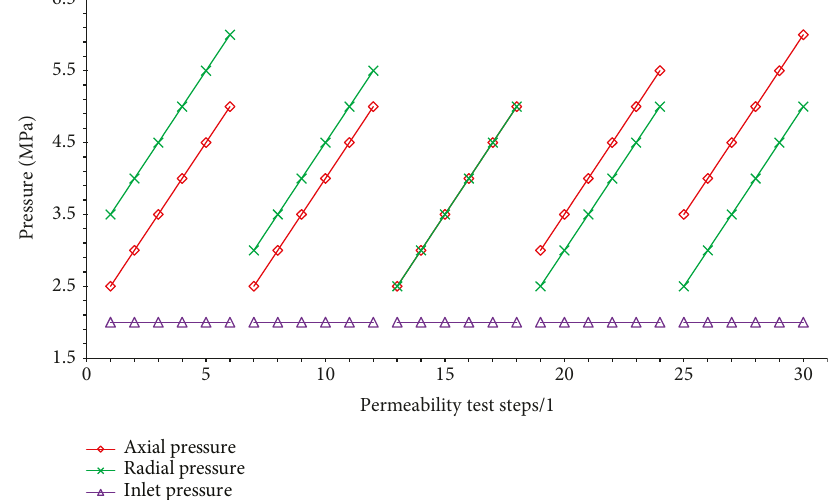
Figure 6: Tests on the pore pressure e ff ect on the permeability under constant e ff ective shear